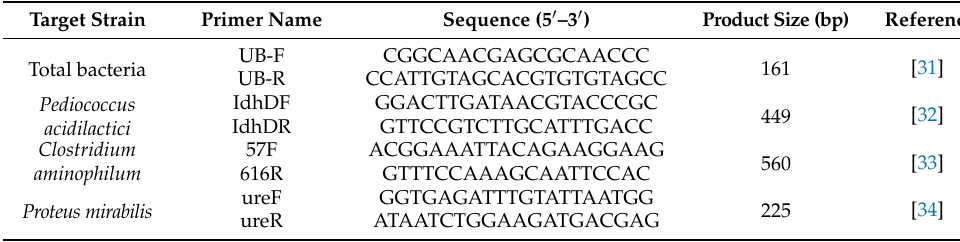
Figure 1. Linear correlation between the log of DNA concentration of microbial single cultures and Ct values from qPCR analysis. Each reaction was performed in triplicate. UB, universal bacteria; PA, Pediococcus acidilactici ; CA, Clostridium aminophilum ; PM, Proteus mirabilis . ( A ) L12I, ( B ) 12III, ( C ) Clostridium aminophilum KCTC 5424, ( D ) Proteus mirabilis KCTC 2510. Table 1. List of PCR primer pairs used for qPCR